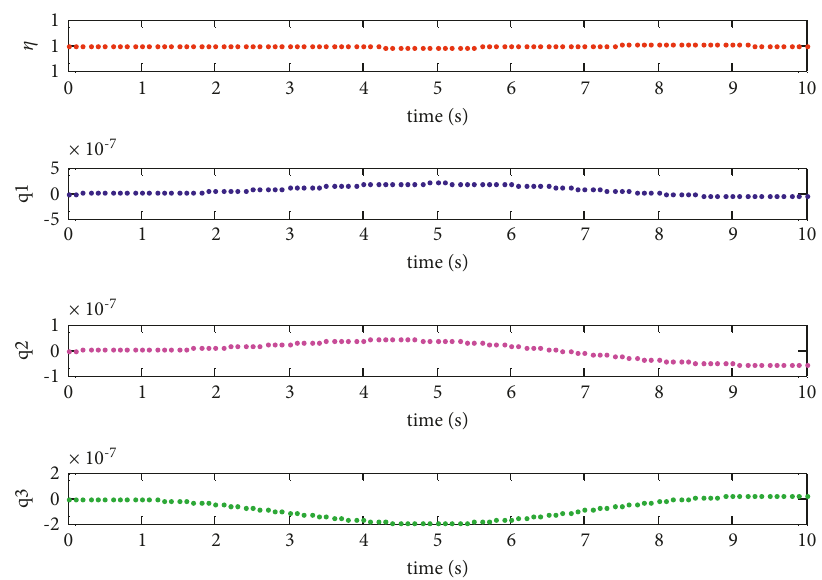
Figure 6: The attitude of the base obtained by the IQPSO algorithm.